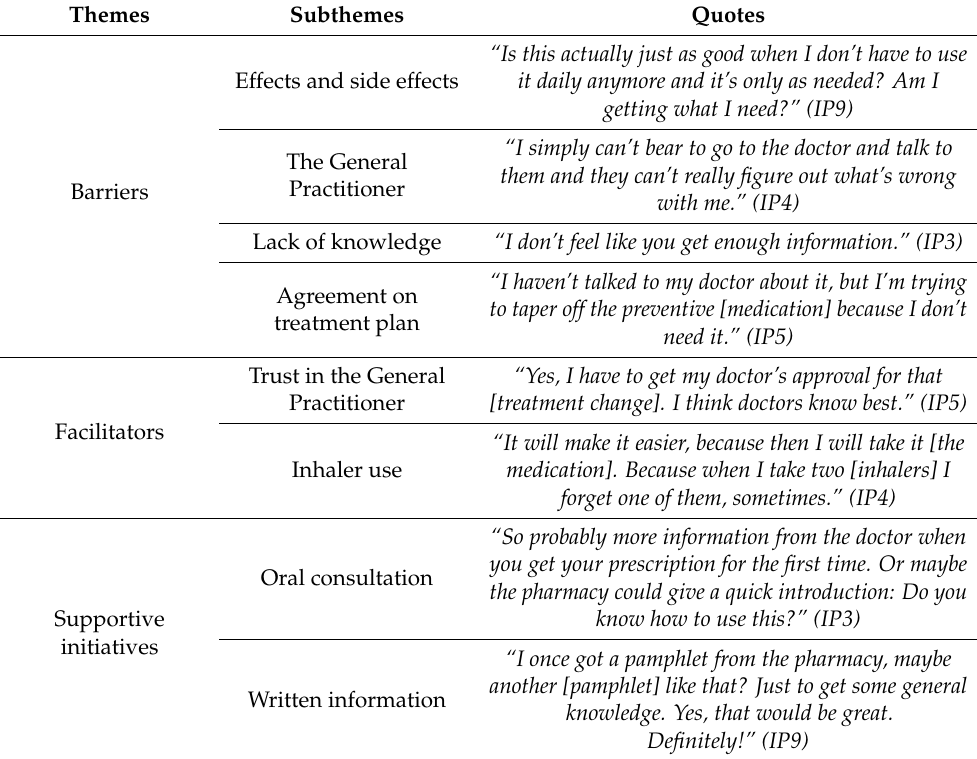
Table 3. Interview themes, subthemes and examples of